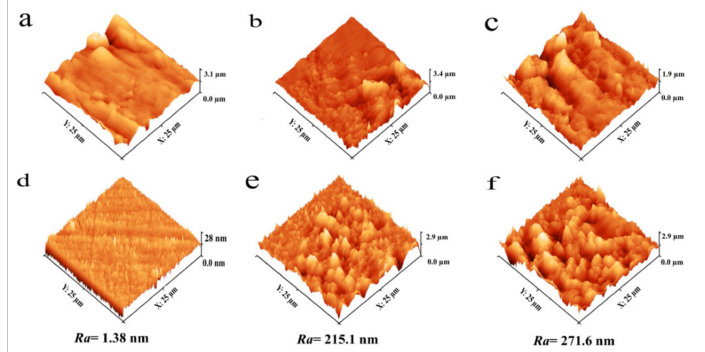
Figure 4. Three-dimensional atomic force microscopy (AFM) images of ( a ) uncoated wood, ( b ) TiO 2 -coated wood at deposition velocity 80 mm / s, ( c ) TiO 2 -coated wood at deposition velocity 40 mm / s, ( d ) uncoated glass, ( e ) TiO 2 -coated glass at deposition velocity 80 mm / s and ( f ) TiO 2 -coated glass at deposition velocity 40 mm /